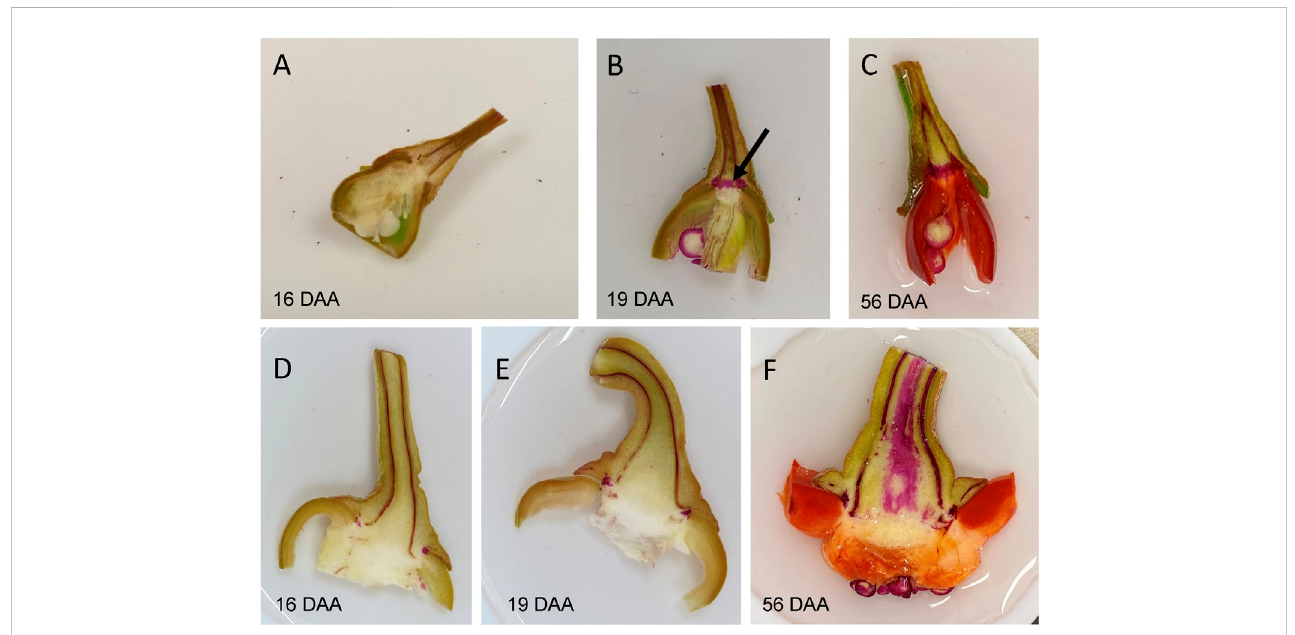
FIGURE 4 Phloroglucinol staining for lignin in fresh longitudinal cuts through the proximal end of fruit with pedicel of developing UCD14 (A – C) and Maor (D – F) fruits. (B) Ligni fi cation, indicatedbyred staining, oftheregion between thefruitandpedicel of UCD14fruits(arrow)was fi rstobservedat19 daysafter anthesis (DAA). (F) There was no sign of ligni fi cation between fruit and pedicel of the non-destemming line, Maor, even at the red ripe stage (56